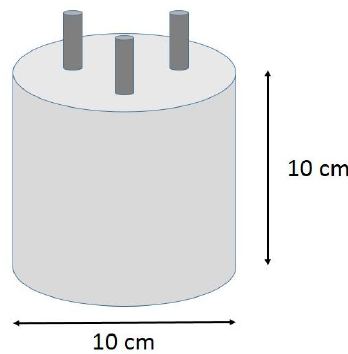
Figure 13. Concrete specimen scheme for corrosion tests. Dimensions in cm. Concrete cover = 3 cm. Distance between electrodes = 3